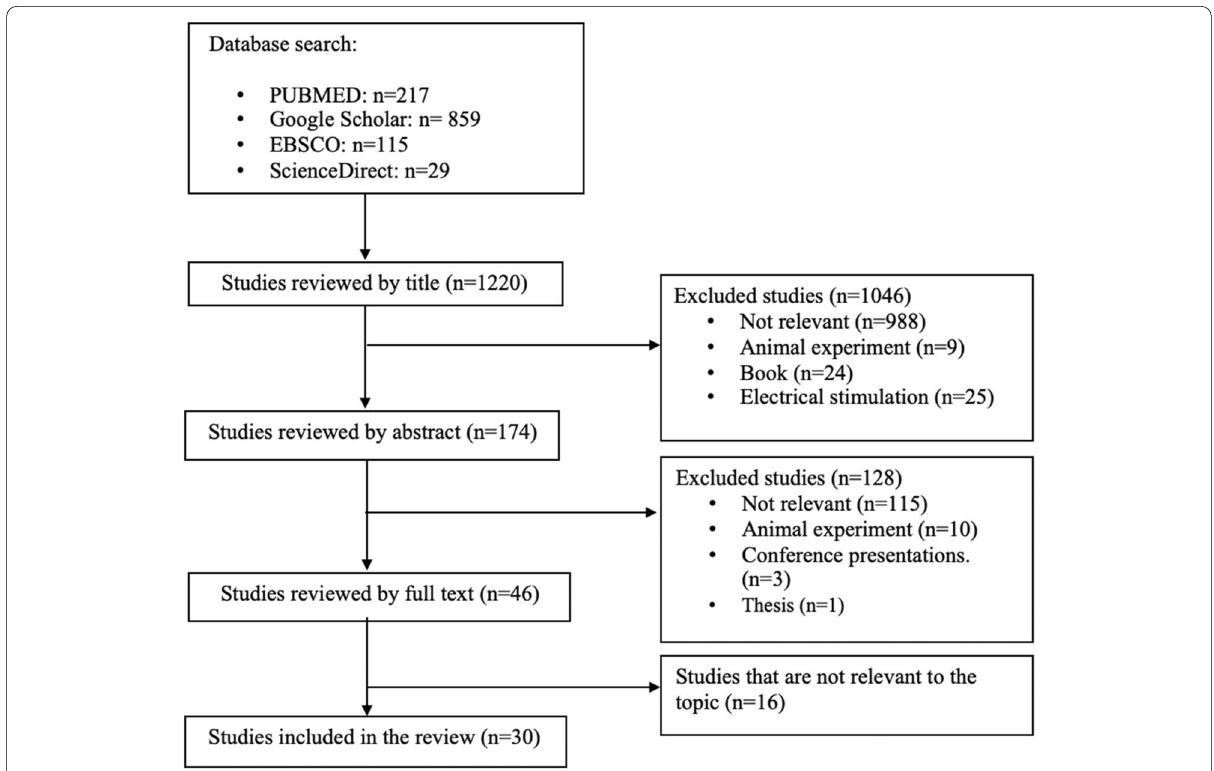
Fig. 1 Flowchart of articles through screening and selection